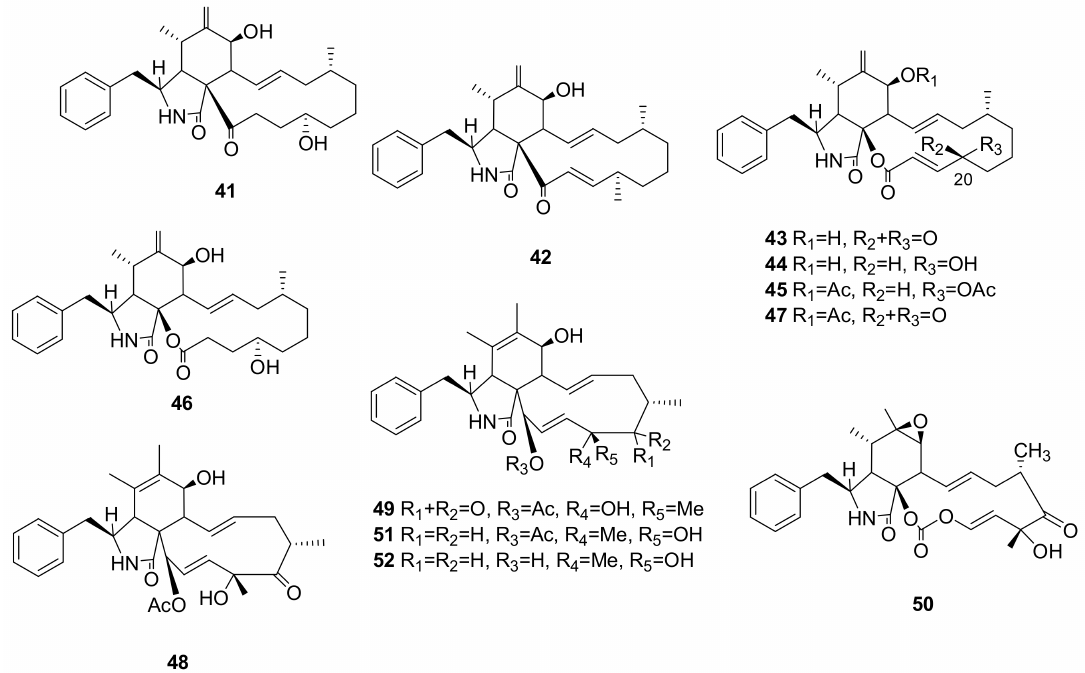
Figure 3. The structures of ascochalasin ( 41 ); deoxaphomin ( 42 ); cytochalasin A ( 43 ); cytochalasin B ( 44 ); 7,20- O , O (cid:48) -diacetylcytochalasin B ( 45 ); 21,22-dihydrocytochalasin B ( 46 ); 17- O -acetylcytochalasin A ( 47 ); and cytochalasins C, D, E, H, and J ( 48 – 52 ,